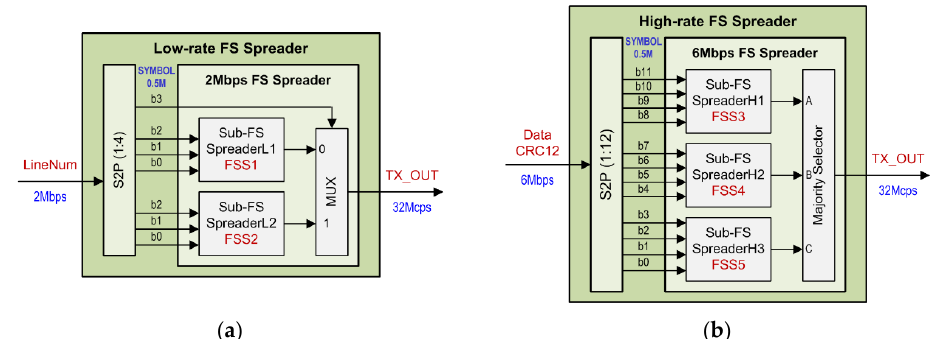
Figure 5. Block-diagram of the dual-mode frequency selective digital transmission (FSDT): ( a ) Low-rate FS spreader; ( b ) High-rate FS